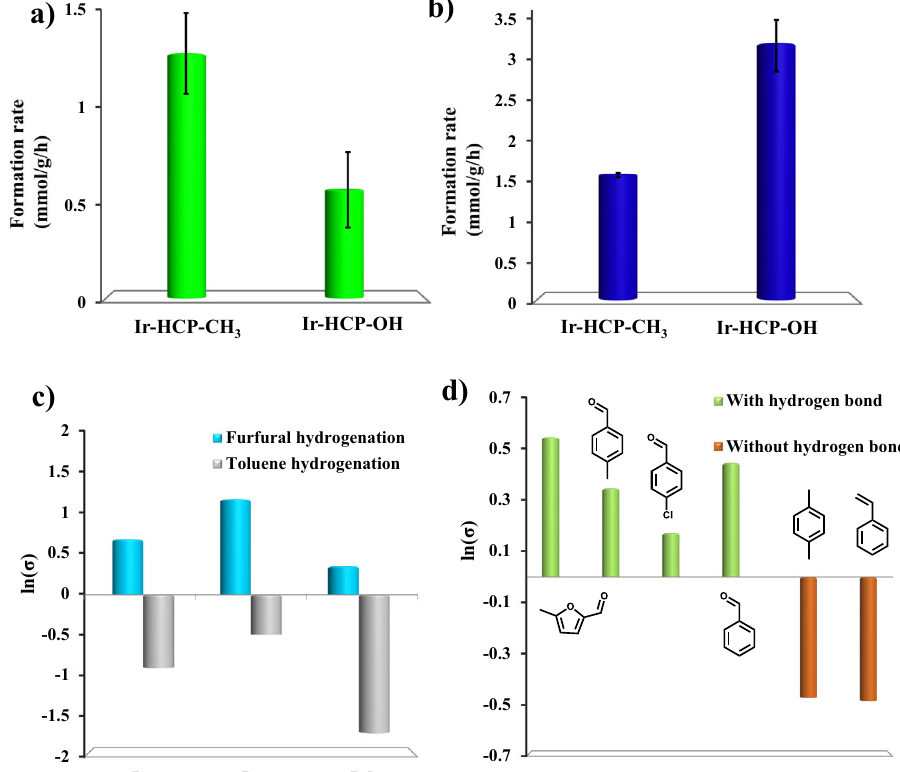
Fig. 3 | Catalyst performance for different substrates. Reaction rate difference ( a ) in toluene hydrogenation, ( b ) in furfural hydrogenation, ( c ) over different metals, and ( d ) of multiple aromatic substrates. σ =Rate Ir-HCP-OH /Rate Ir-HCP-CH3,